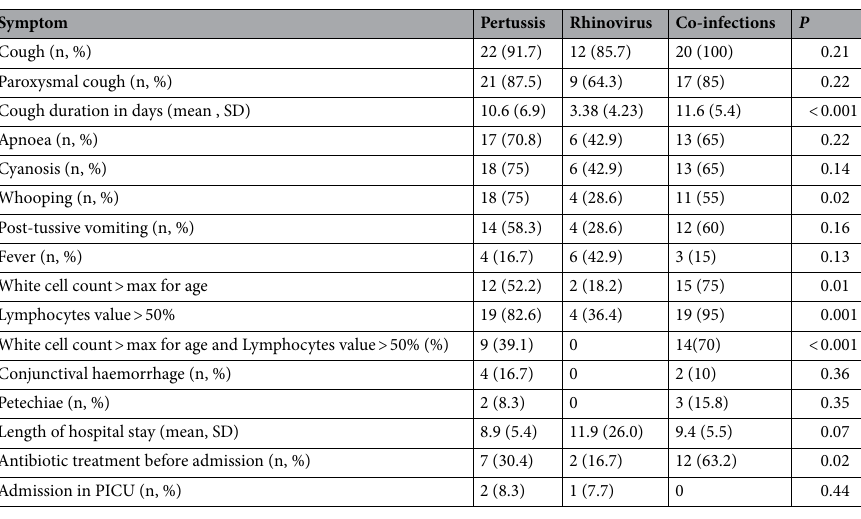
Table 2. Clinical characteristics of patients by type of